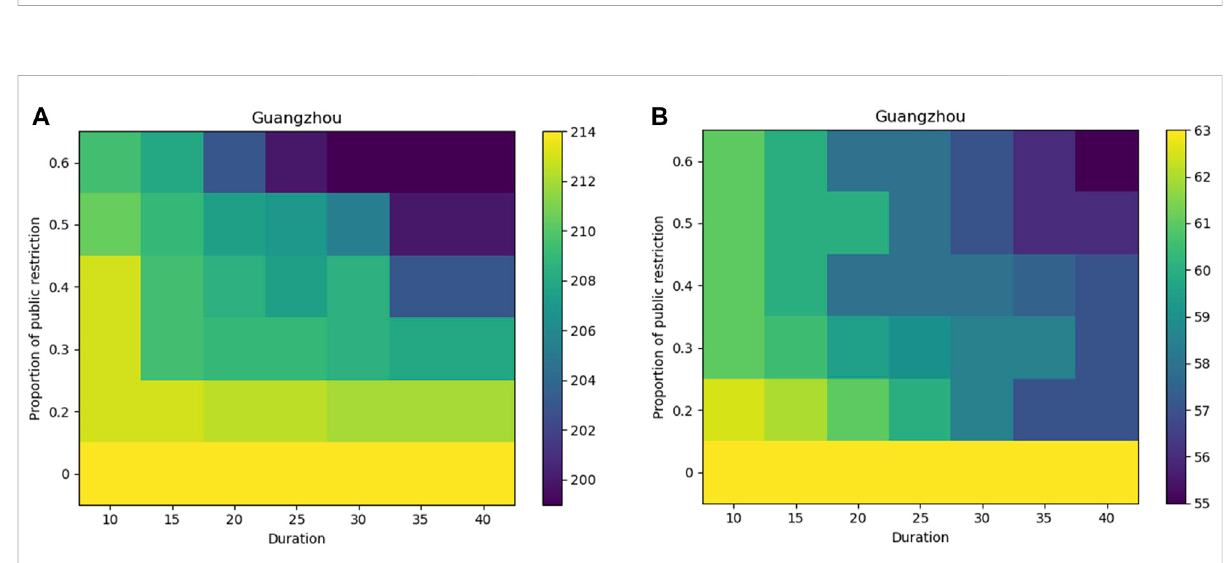
FIGURE 8 Effect of suspension of public transportation service. Higher proportion or longer duration of suspension of public transportation service denotes more severe NPIs. We take the total number of infections (A) and the duration of the epidemic (B) as an evaluation